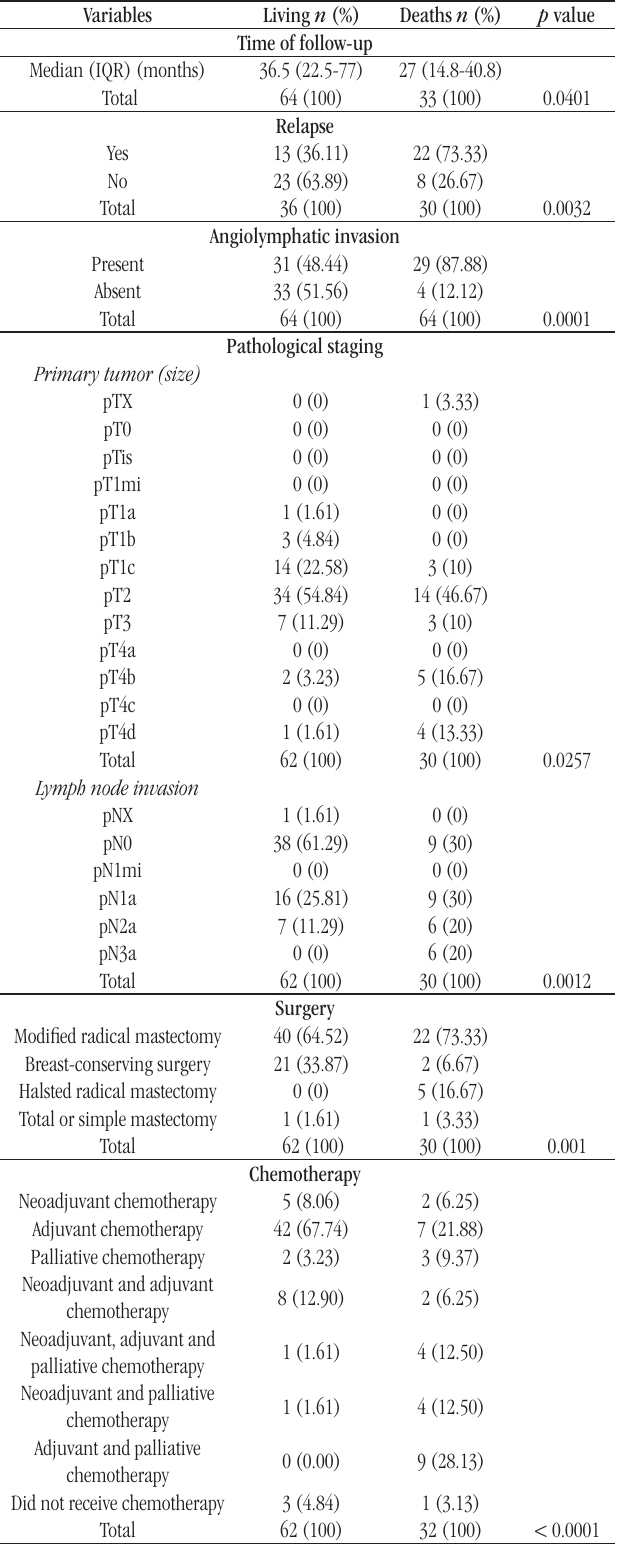
taBLE 5 − Significant clinicopathological and treatment